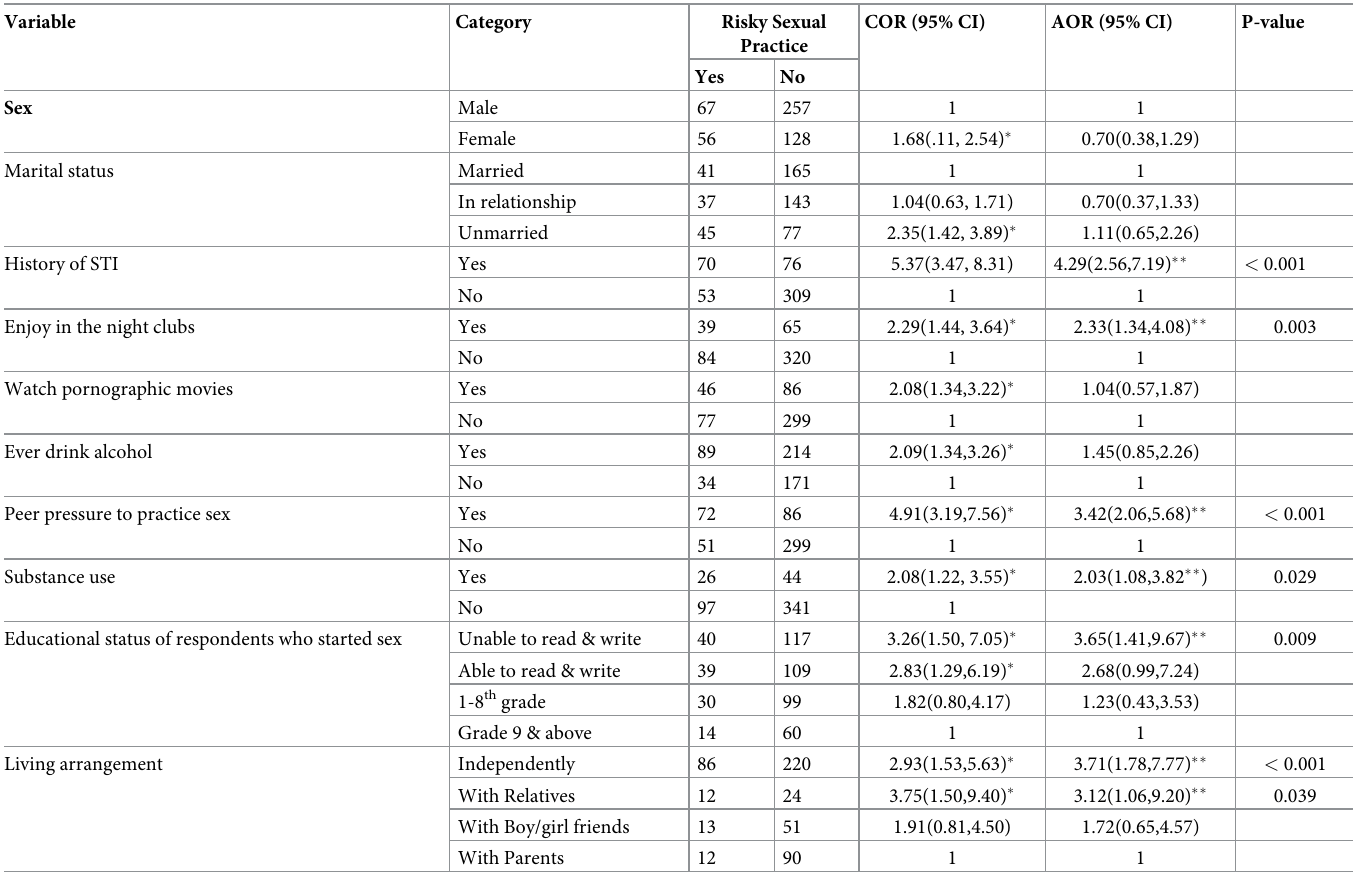
Table 4. Factor analysis of predictor variables for risky sexual practice among big construction site daily laborers, Bahir Dar